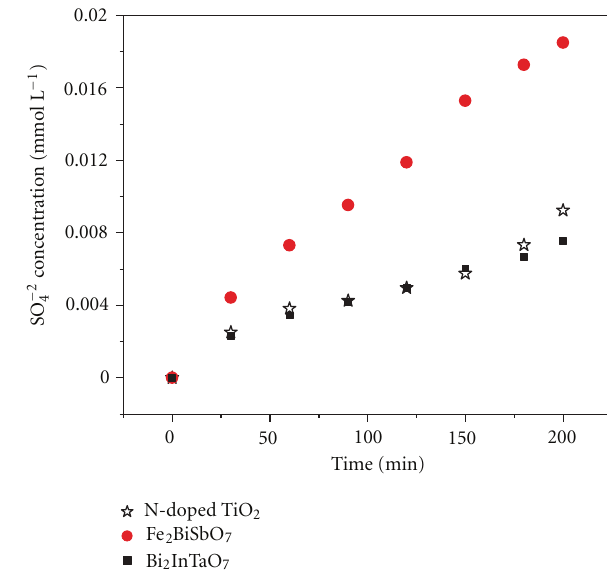
Figure 7: The concentration variation of SO 42 − during photocat- alytic degradation of methylene blue with Fe 2 BiSbO 7 , Bi 2 InTaO 7 , or N-doped TiO 2 as catalyst under visible light irradiation.